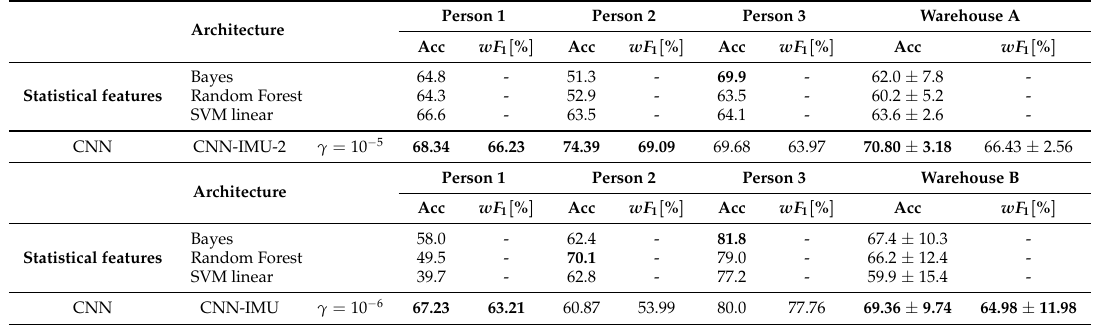
Table 15. Comparison between the best performances using CNNs and statistical features on the order picking dataset for warehouses A and B